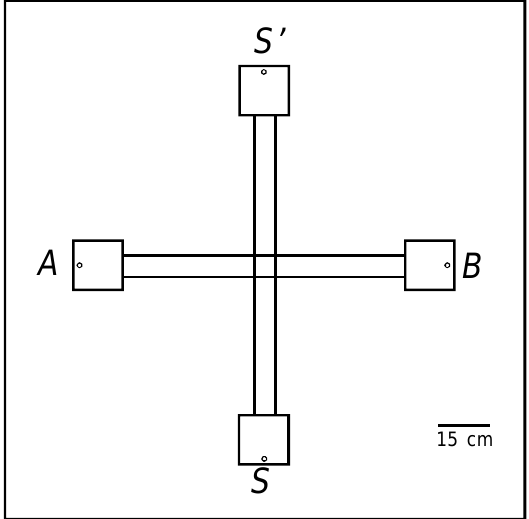
Figura 1 . Labirinto em MAIS. S e S’, caixas de saída; A e B, caixas